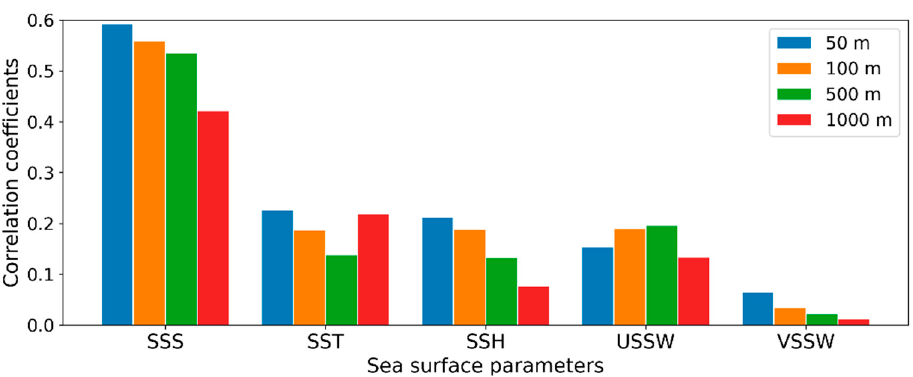
Figure 5. Correlation coefficients between the sea surface parameters (SSS, SST, SSH, USSW, and VSSW) and the Argo-observed OSSS at 50 m (blue), 100 m (orange), 500 m (green), and 1000 m (red) from January 2010 to December 2019.